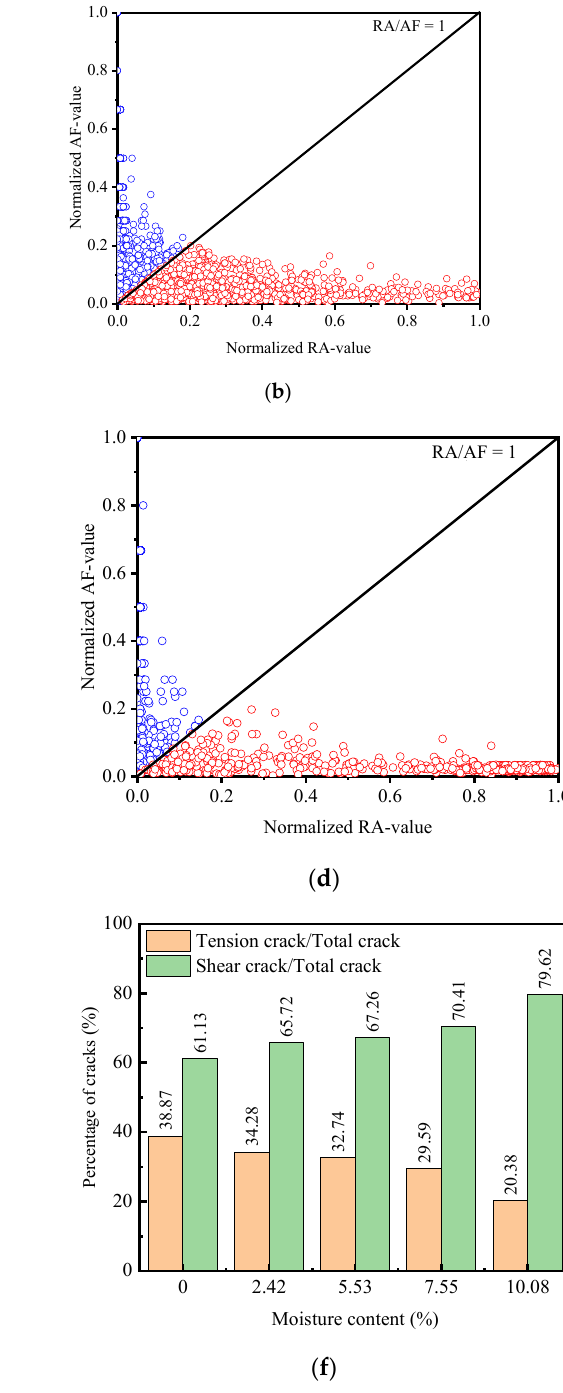
Figure 12. Evolution of tension–shear cracks in coal specimens at different inclination angles ( θ = 10°). ( a ) ω = 0%; ( b ) ω = 2.42%; ( c ) ω = 5.53%; ( d ) ω = 7.55%; ( e ) ω = 10.08%; ( f ) The ratio of tensile and shear cracks in coal specimens under different moisture contents.